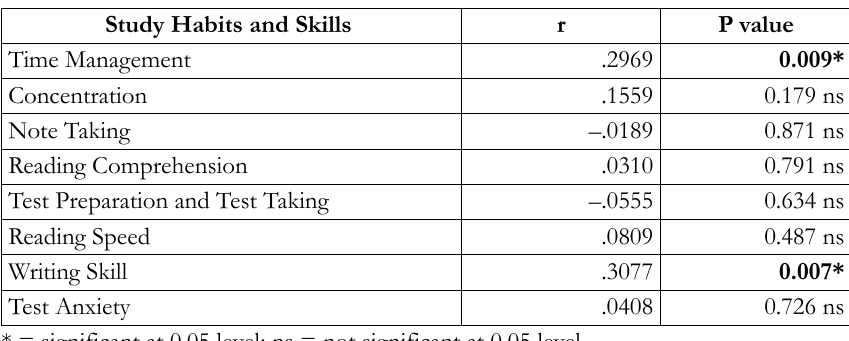
Table 8. Correlation between Academic Achievement and Study Habits and